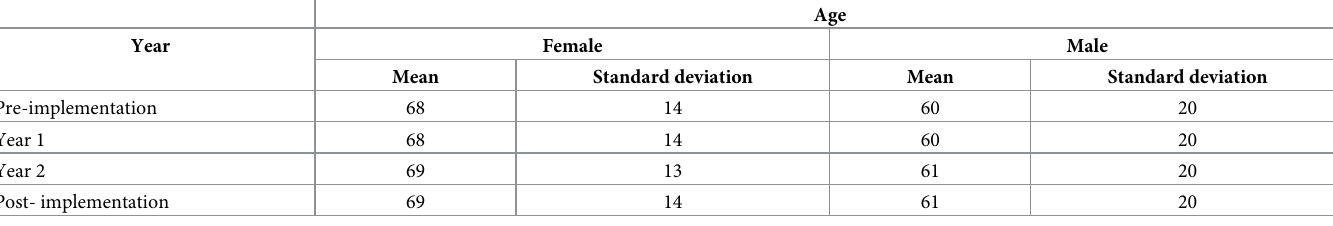
Table 1. Mean age of Ontario patients in CPERS a by gender and fiscal